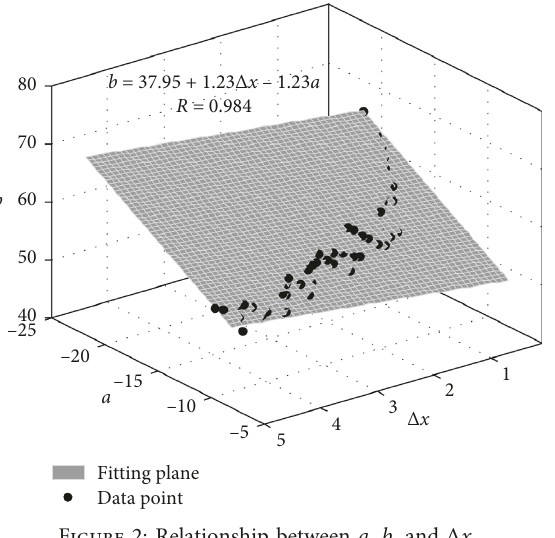
Figure 2: Relationship between a , b , and Δ x .